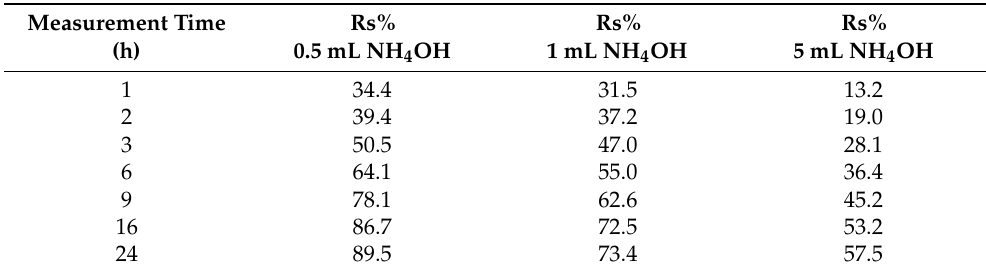
Table 2. Sorption rate for NH 3 eliminated from air contaminated with 0.5 mL, 1 mL, and 5 mL NH 4 OH